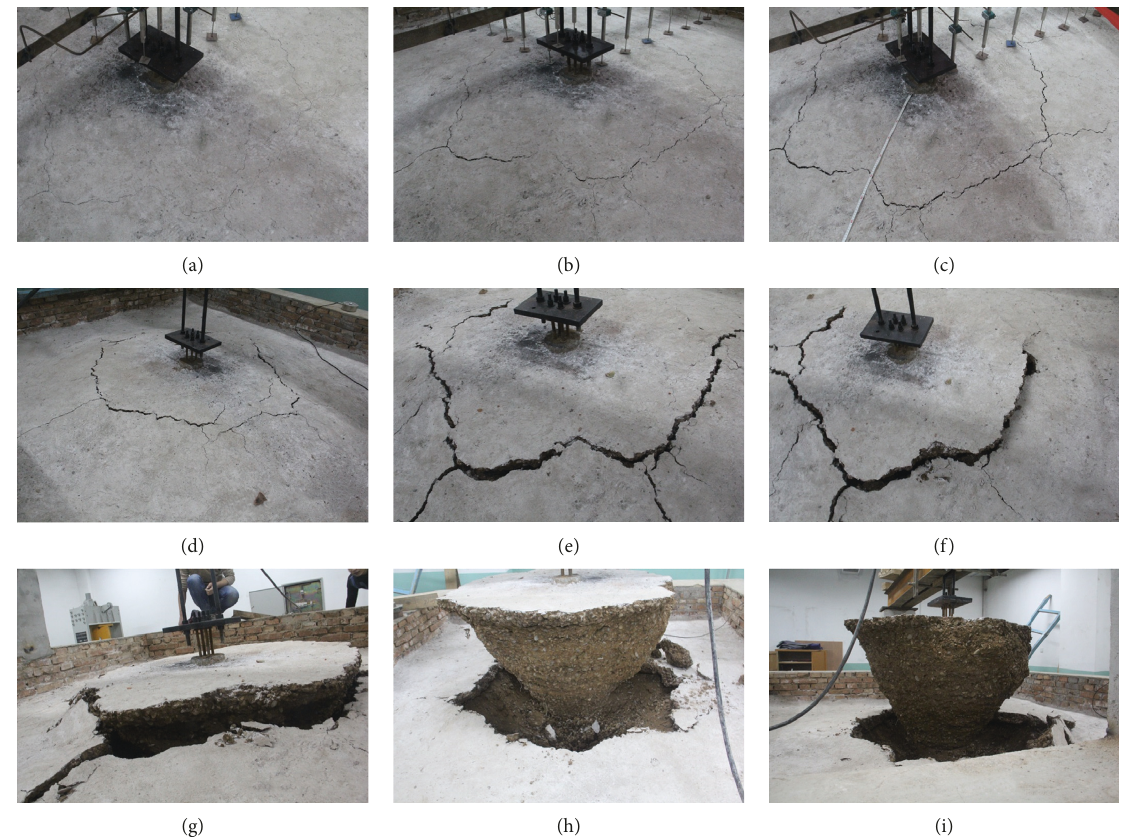
Figure 5: Failure of belled pier foundation during uplift loading. (a) t (f) t 14.5h. (g) t (cid:31)